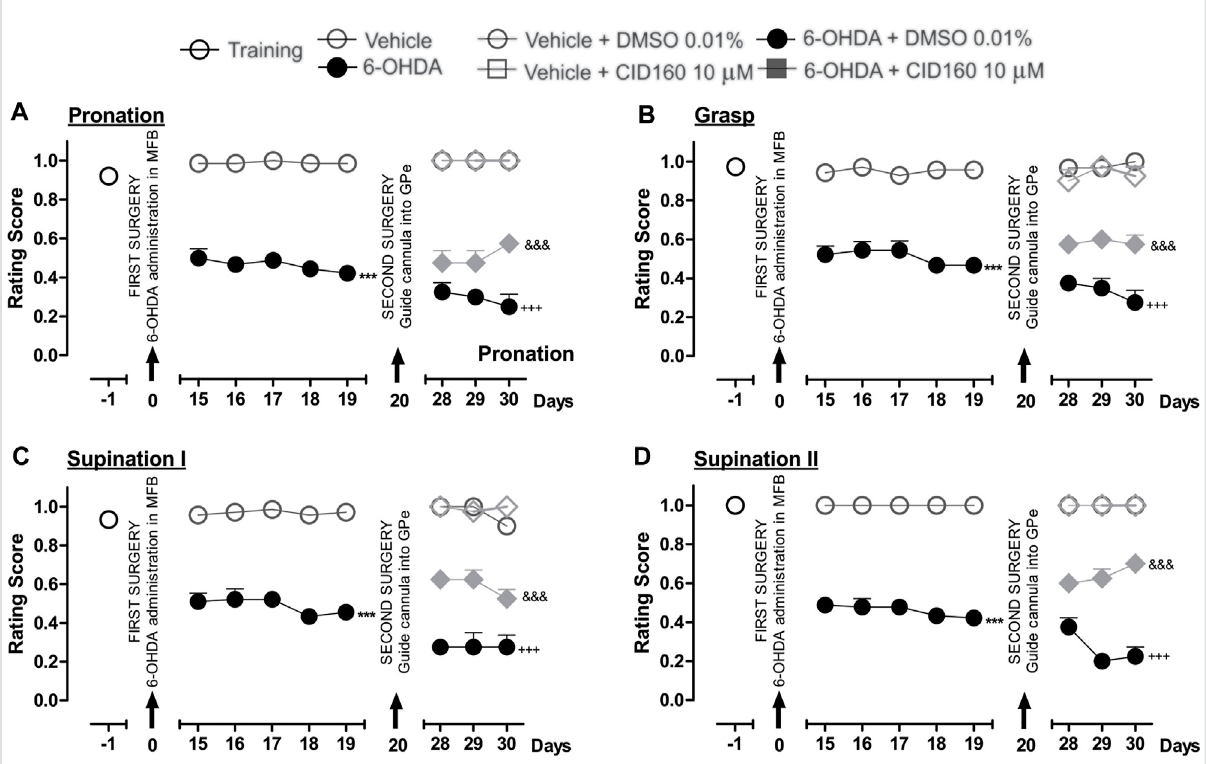
The administration of CID16020046 in the GPe generated superior fi ne motor skills performance in the hemiparkinsonian rats analyzed in the staircase test. The four movement components selected to evaluate thecontralateral forelimb performance for fi nemotor skills were as follows: (A) Pronation; (B) Grasp; (C) Supination I; and, (D) Supination II. The effect of the intrapallidal administration of CID160 (10 µM) on the movement components were evaluated one day prior to the fi rst stereotaxic surgery (from the 15th to the 19th days post-lesion) and from the 28th to